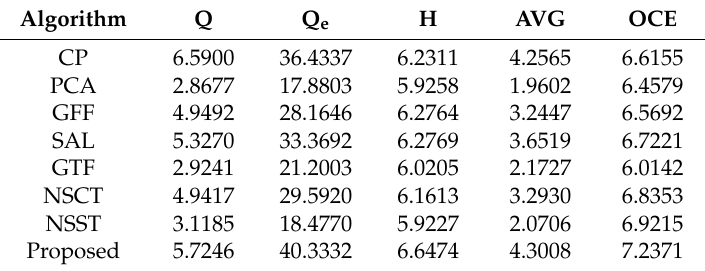
Table 3. Comparison of evaluation results of third experiment.